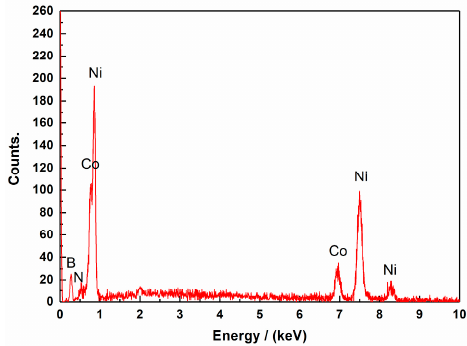
Figure 6. EDS spectra of Ni–Co–BN (h) nanocomposite coatings surface with duty cycle of 0.7 and pulse frequency of 4 kHz.